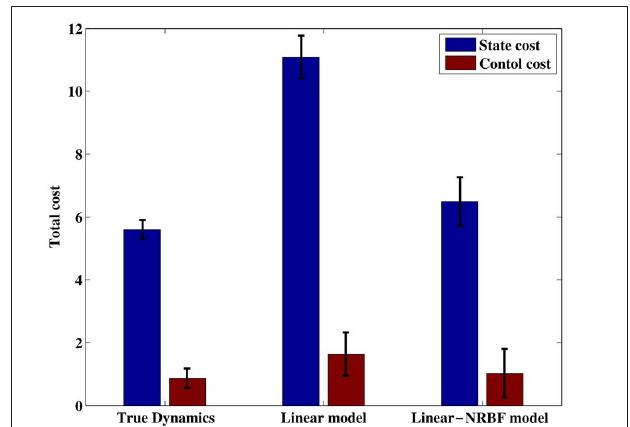
FIGURE 7 | Total costs collected by the obtained control policy. Each error bar represents the standard deviation.